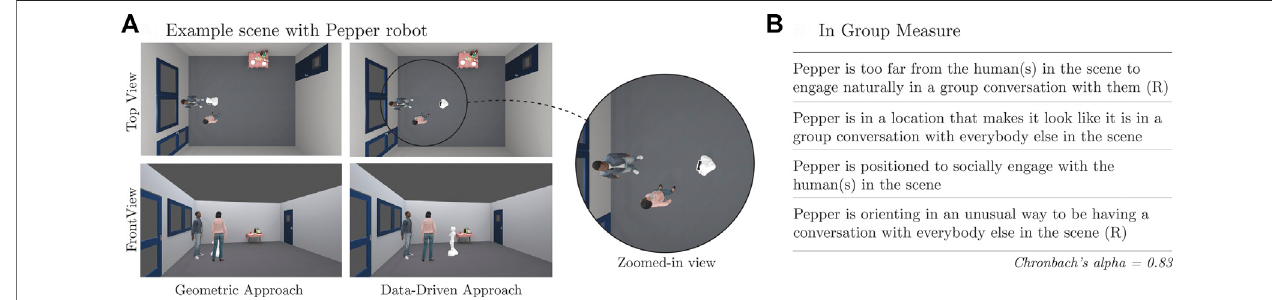
FIGURE 8 | Example scene used for the human evaluation (A) and statements rated by the participants about the robot ’ s pose (B) . (R) indicates that the ratings were reversed before computing the “ In Group ” measure.